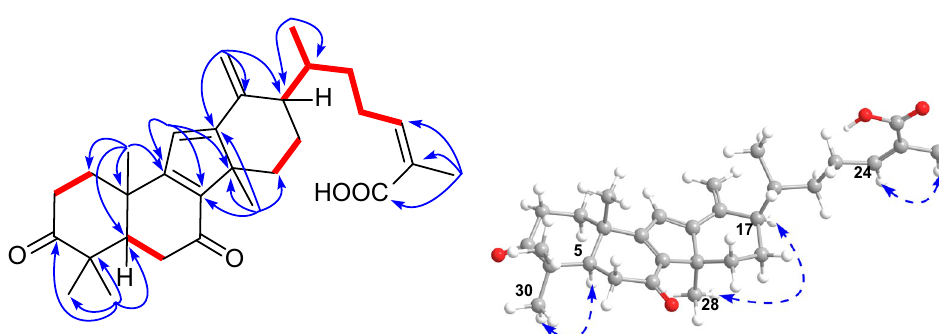
Fig. 4 Key 1 H– 1 H COSY (red and bold), HMBC (blue arrows), and ROESY (dashed arrows) correlations of 3